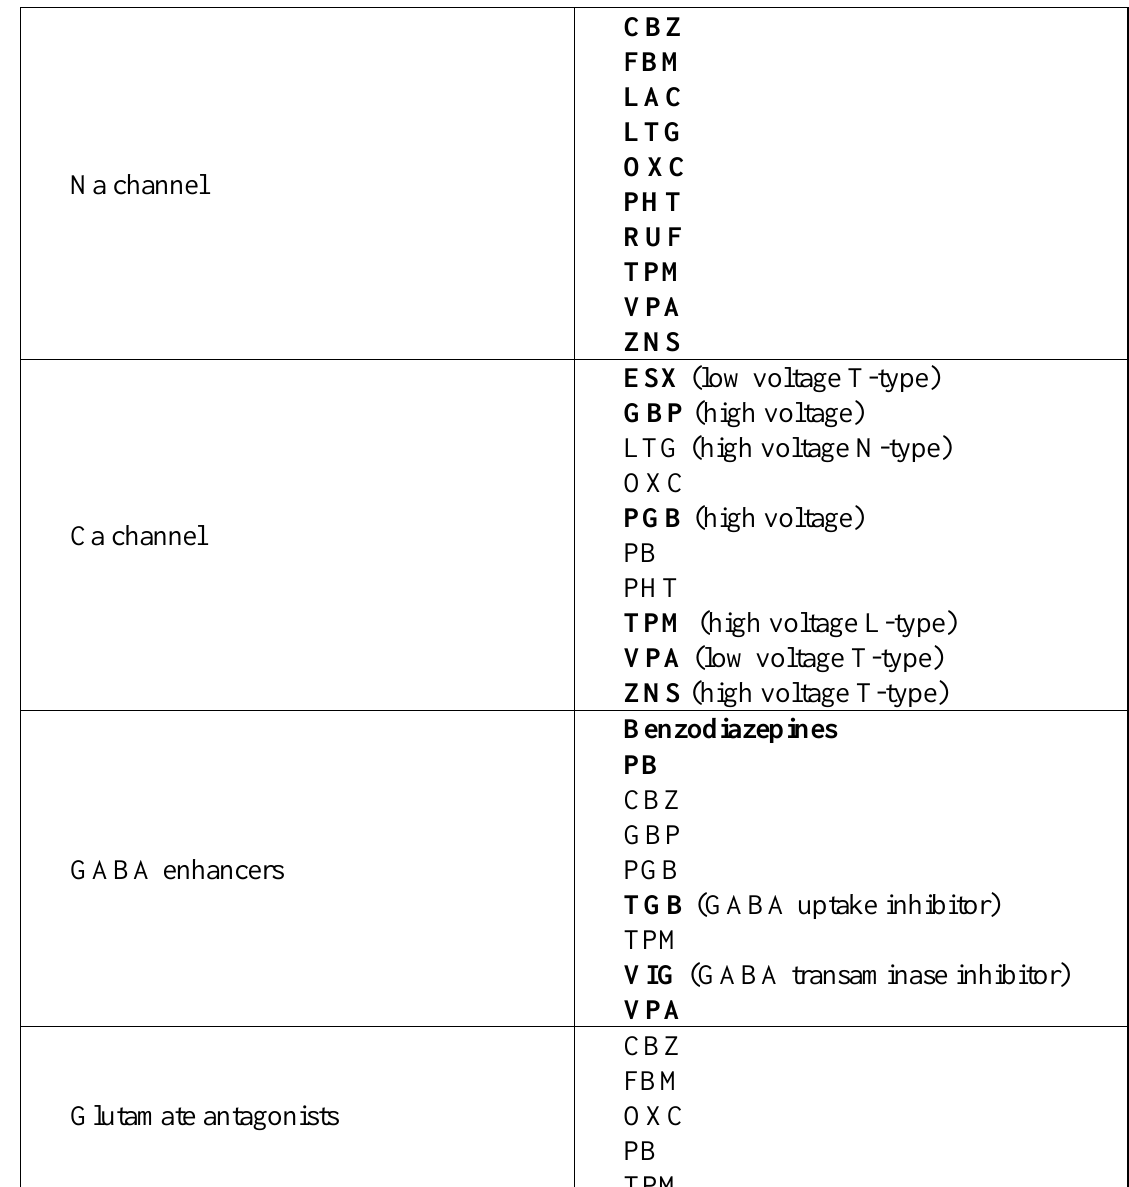
Table 1. AED mechanisms [9,